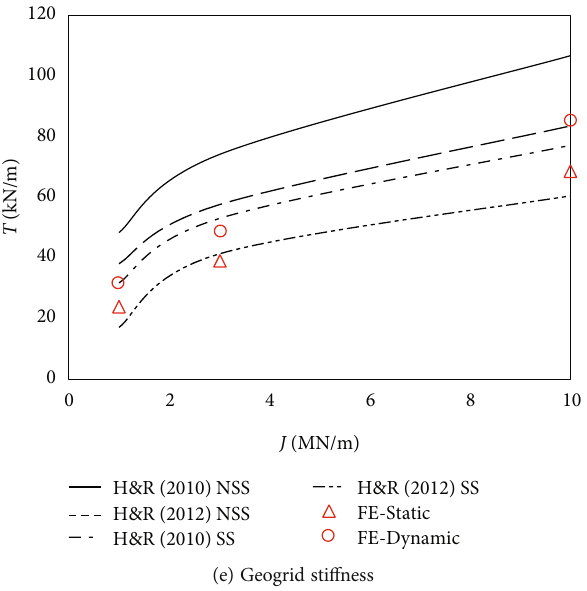
Figure 6: Tensile force of geogrid reinforcement ( T ) with the change of the in fl uencing